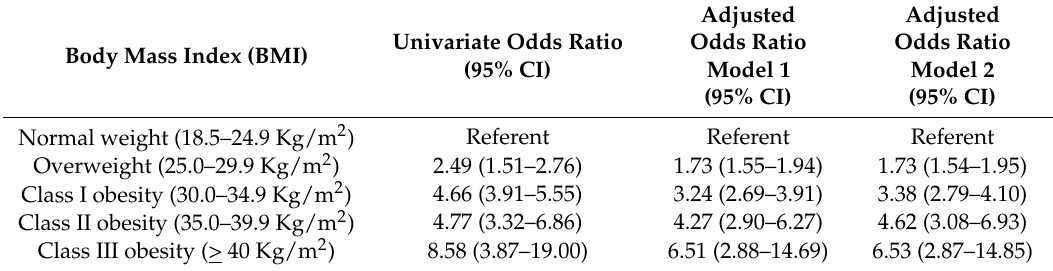
Model 1: adjusted for age and gender; Model 2: adjusted for age, gender, smoking habit, healthy diet, physical activity, cholesterol, and